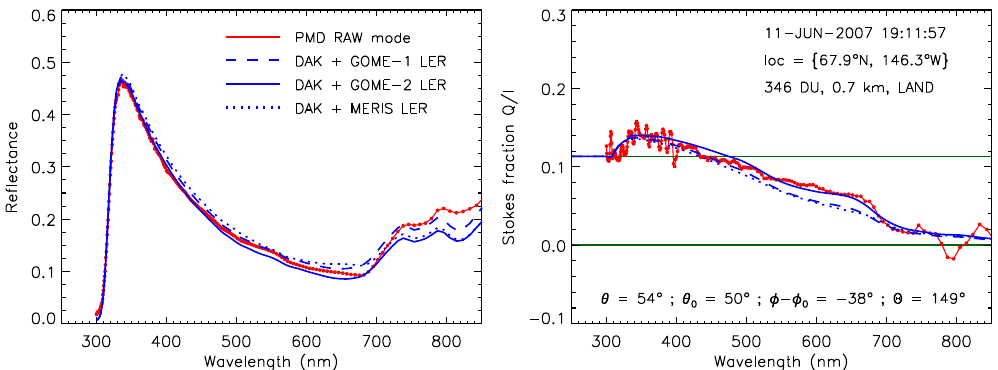
Figure 5. Reflectance and polarisation spectrum measured by GOME-2 for case 3. The agreement between measurement and simulation is good for both reflectance and polarisation for all three surface albedo Fig. 5. Reflectance and polarisation spectrum measured by GOME-2 for case “3”. The